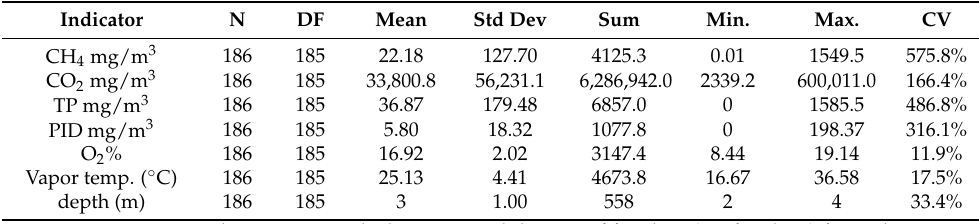
Table 1. Statistical characteristics of numerical